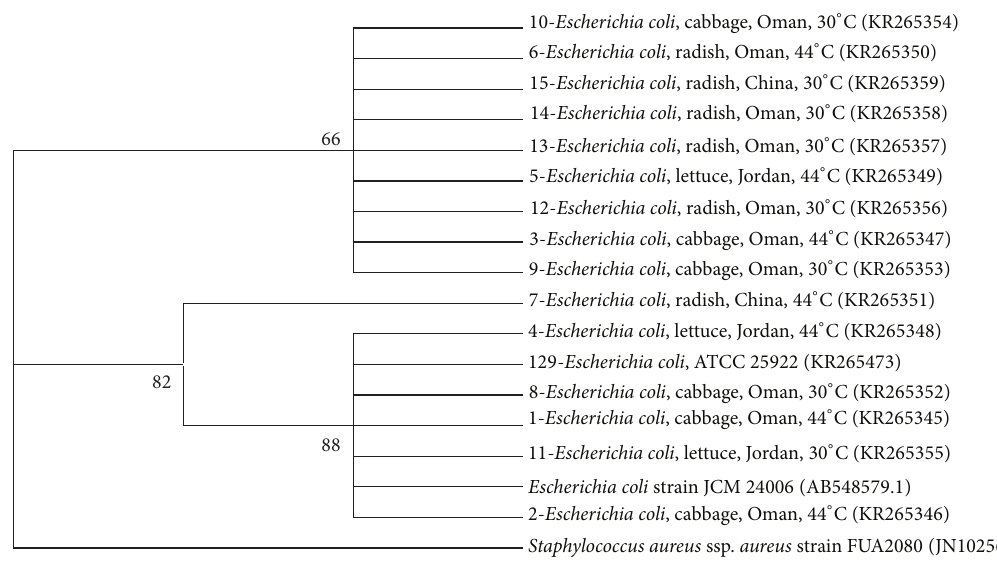
Figure3:Neighborjoiningtreebasedon16SrRNAgenesequencesof E.coli isolatedfromfreshproduce. E.coli strainJCM24006(AB548579) was included as a reference strain and Staphylococcus aureus (JN102565) was included as an outgroup. KR-accession numbers correspond to gene sequences that belong to isolates analyzed in this study while AB548579 and JN102565 were obtained from the NCBI database. Bootstrap values above 50% are shown (1000 replications).